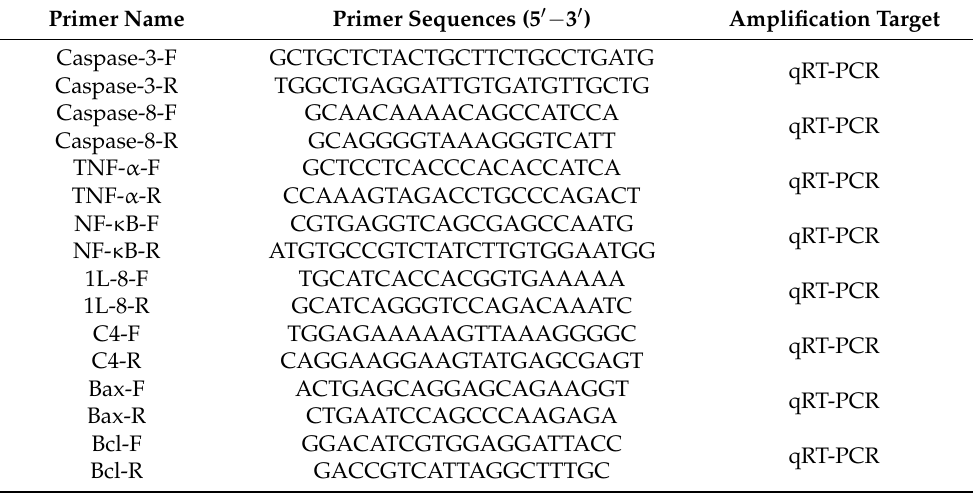
Table 1. Primers used for mRNA expression